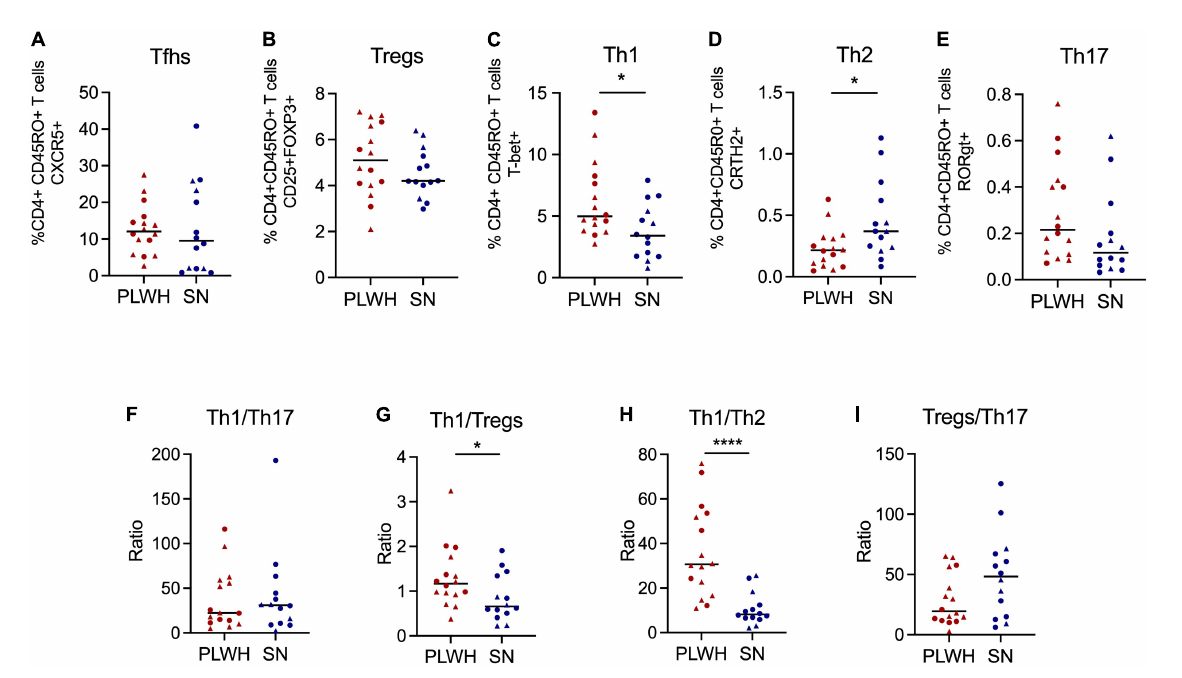
FIGURE3 PLWH have increased frequency of Th1 and decreased of Th2 compared to SN. Adenoids and tonsils were obtained from PLWH and SN. Cells from both anatomical sites were pooled to represent the NALT. The frequency (%) of CD4+ T cell subpopulations was assessed by flow cytometry. The frequency of (A) Tfhs (CD3+CD4+CD45RO+CXCR5+), (B) Tregs (CD3+CD4+CD45RO+CD25+FOXP3), (C) Th1 (CD3+CD4+CD45RO+T-bet+), (D) Th2 (CD3+CD4+CD45RO+CRTH2+), and (E) Th17 (CD3+CD4+CD45RO+RORgt+) are shown. The ratios of (F) Th1/Th17, (G) Th1/Tregs, (H) Th1/Th2, and (I) Tregs/Th17 were also determined. Scatter plots were used to present the data. The median is shown by a horizontal line. Each symbol represents one individual. Red triangle: PLWH tonsils, red circle: PLWH adenoids, blue triangle: SN tonsils, and blue circle: SN adenoids. Data was compared using the Wilcoxon Rank Sum test. Only p values < 0.05 are shown in graphs. * p < 0.01; ** p < 0.001. %, frequency; CRTH2, chemoattractant receptor-homologous molecule expressed on TH2 cells; FOXP3, forkhead box #P3 protein; HIV, human immunodeficiency virus; PLWH, people living with HIV; NALT, nasopharyngeal-associated lymphoid tissue; RORgt, retinoic acid-related orphan receptor-gammat; SN, seronegative; Tfhs, T follicular helper cells; Th, T helper; and Tregs, T